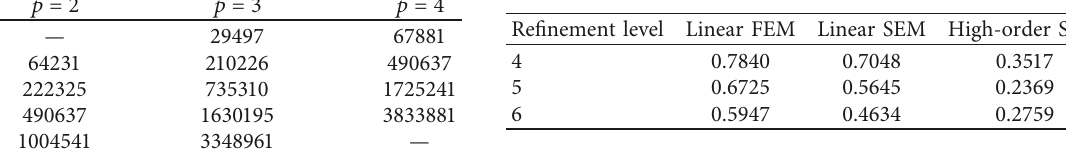
— — Table 7: L 2 norm of the dynamic condensation distribution at 20ms.